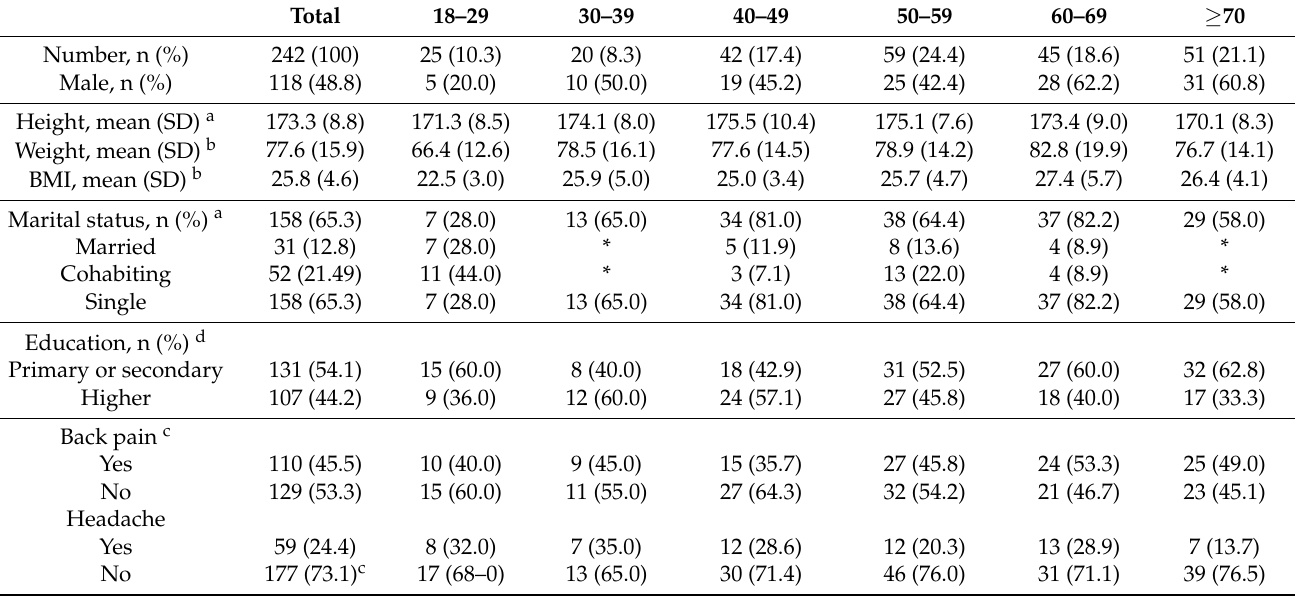
Table 1. Population Characteristics According to Age